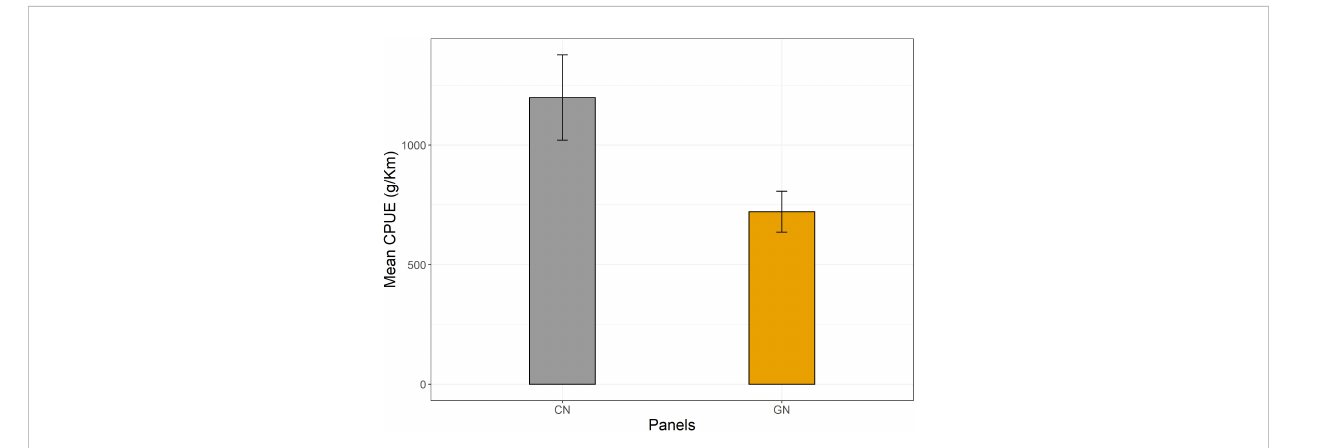
FIGURE 7 Mean catch per unit effort expressed as g/km of Posidonia oceanica per commercial (CN) and modi fi ed (GN) panel,